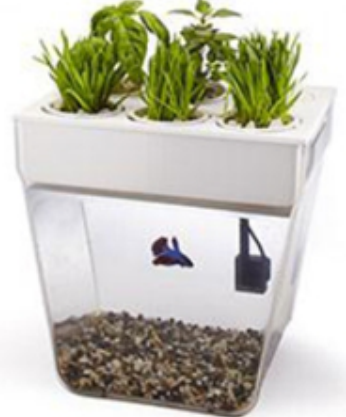
Figure 4. Aquafarm (Back to the Roots, 2015a)